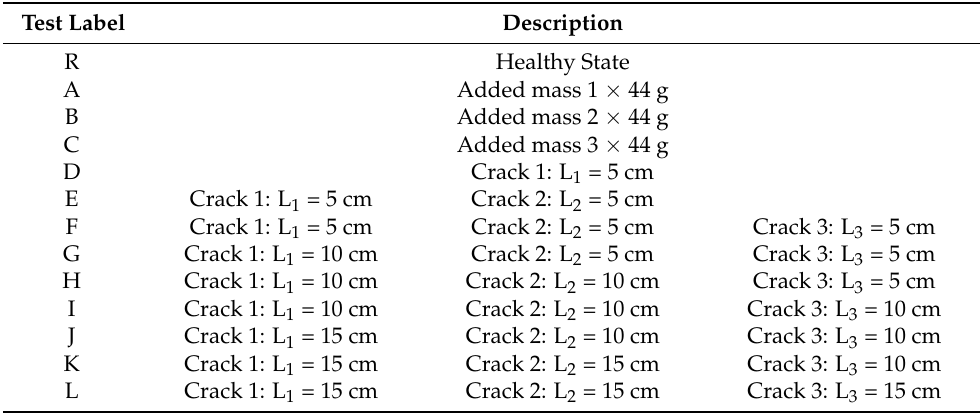
Table 2. Details of the controlled tests of the wind turbine blade [58].